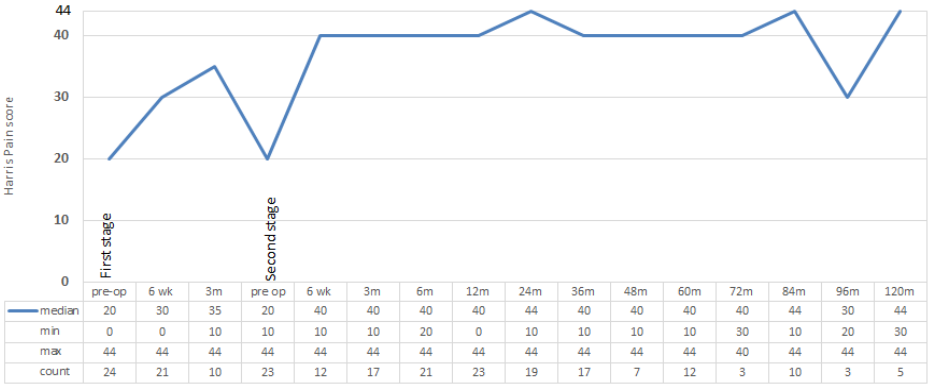
Figure 3. Harris Pain Scores. Harris pain: 44 = none, 40 = slight, 30 = mild, 20 = moderate, 10 = marked, and 0 = totally disabled. Median patient-reported activity after last revision increased by one rating, from sedentary to semi-sedentary between 3 and 36 months and up to light labor at 48, 72, and 84 months post-operatively (Figure 4). After the last revision, there was a significant improvement in activity at 12 months relative to that recorded pre-operatively ( p = 0.042).